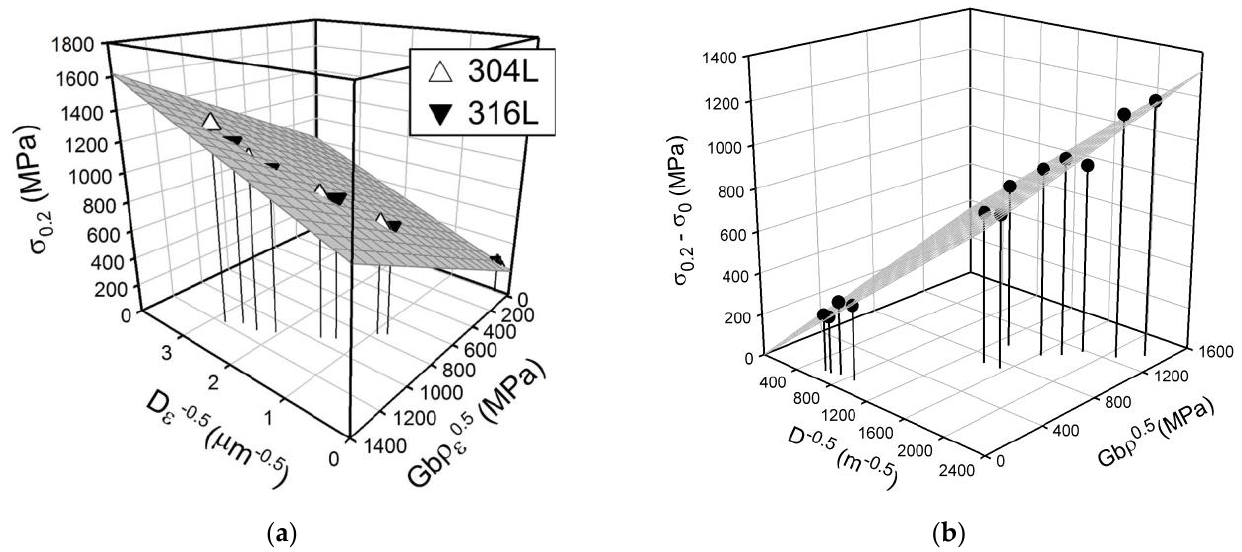
Figure 33. Effects of the grain size (D) and dislocation density ( ρ ) on the strength of UFG 304L and 316L steels processed by rolling at 473 K ( a ) and UFG 316L steel processed by cold or warm rolling and subsequent annealing ( b ) [68,108].